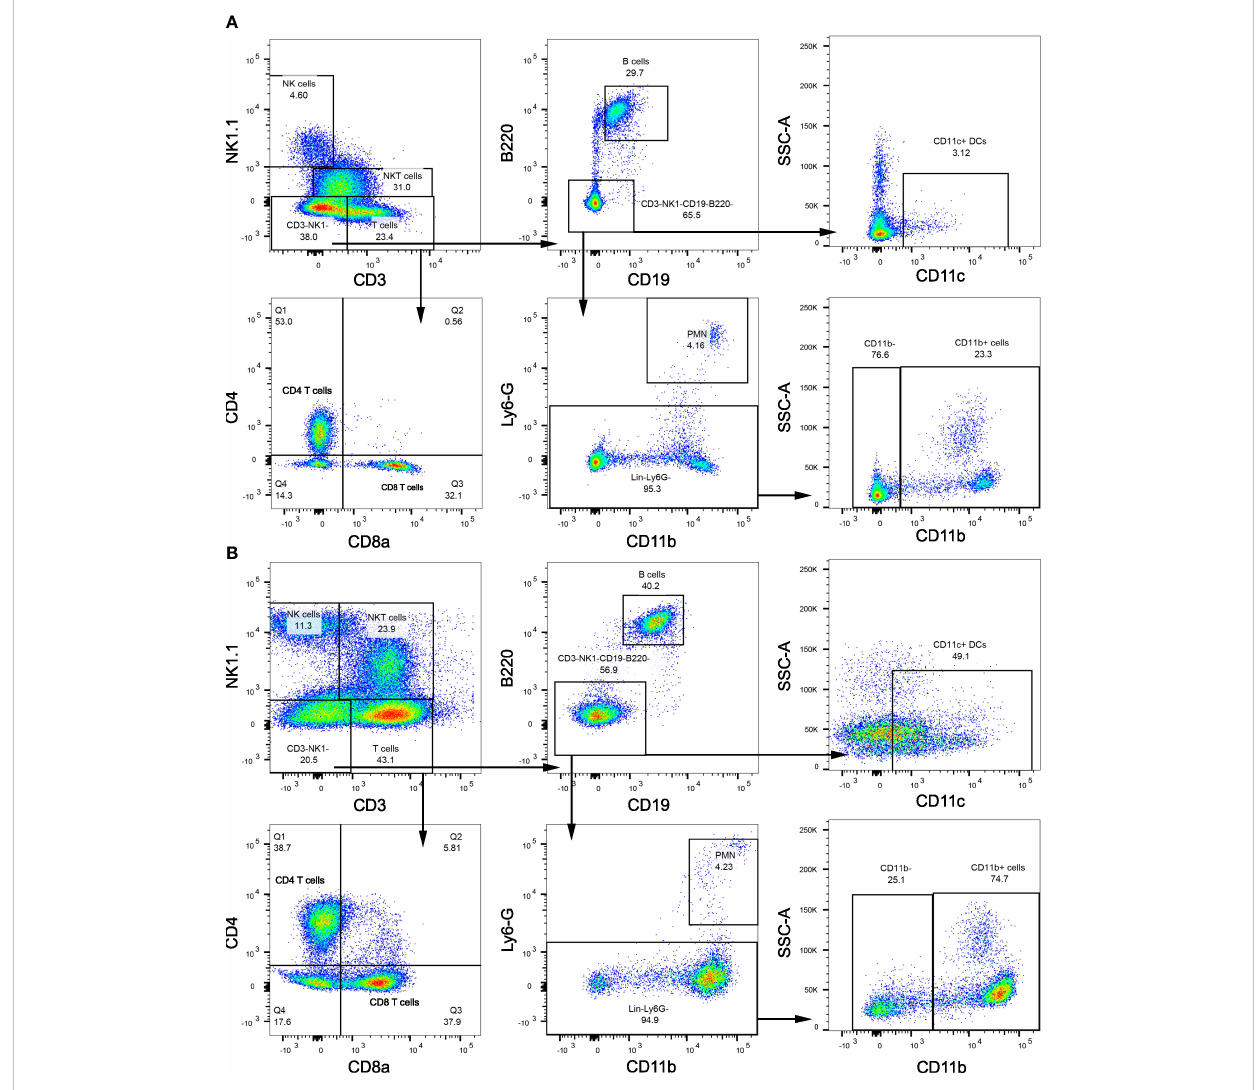
FIGURE 3 Flow cytometry gating strategy. (A) Flow cytometry gating strategy that is used to isolate immune populations within the liver of CD-fed mice and (B) FFC-fed mice. Immune populations were identi fi ed as follows: NK cells (CD3 - NK1.1 + ), NKT cells (CD3 + NK1.1 + ), B cells (CD3 - NK1.1 - CD19 + B220 + ), DCs (CD3 - NK1.1 - CD19 - B220 - CD11c + ), PMNs (CD11b + Ly6G - ), CD11b + myeloid cells (CD11b + Ly6G - ). T cells (CD3 + NK1.1 - ) were selected for further analysis to identify CD4 T cells (CD3 + NK1.1 - CD4 + CD8a - ), CD8 T cells (CD3 + NK1.1 - CD4 - CD8a + ) and DNT cells (CD3 + NK1.1 - CD4 - CD8a -